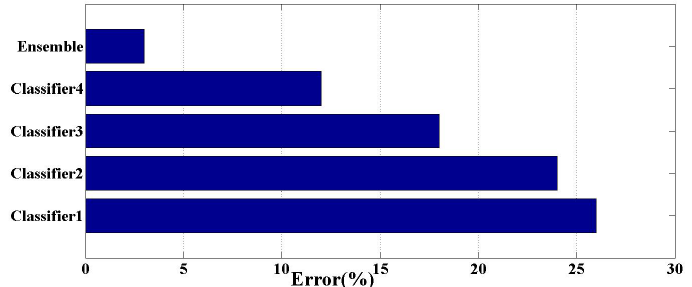
Figure 14. Error (%) for different classifiers when the test dataset is D5-SPT-Tst calculated using Equation (6), considering both accelerometer and gyroscope